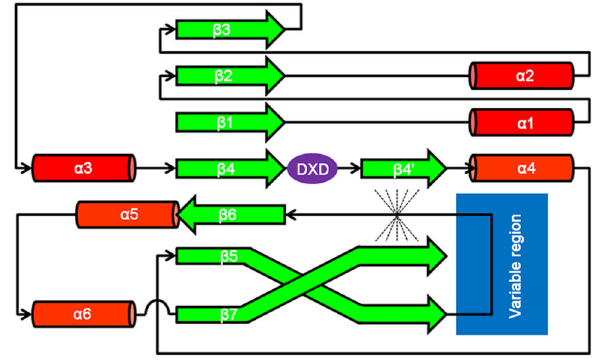
Figure 3. Consensus topology map for GT-A proteins. It is based on the structural superimposition of the 3D structures of solved GT-A enzymes in Table 1 (Figure S2).